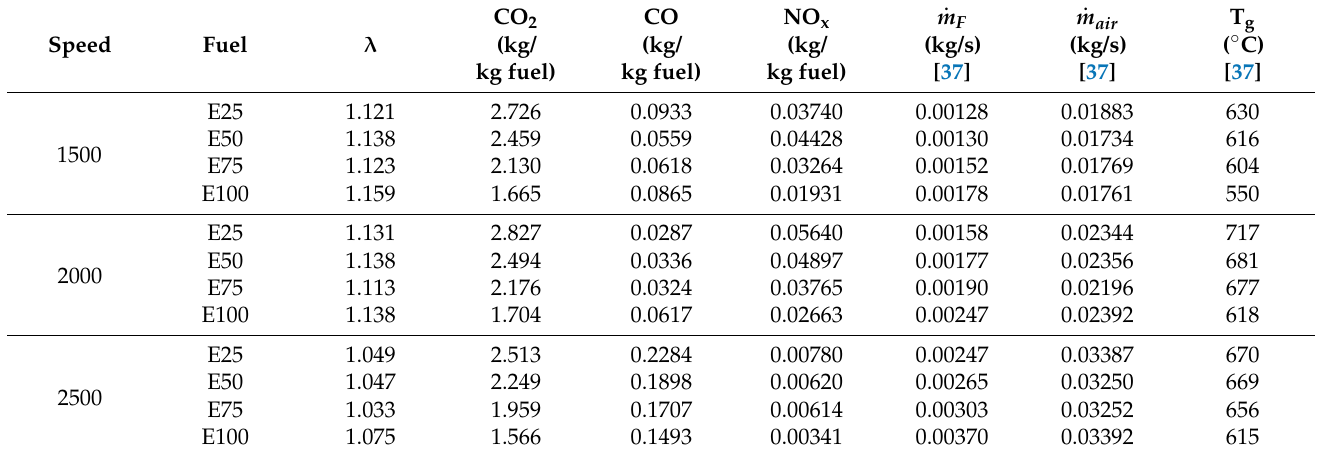
Table 4. Combustion analysis and thermodynamic